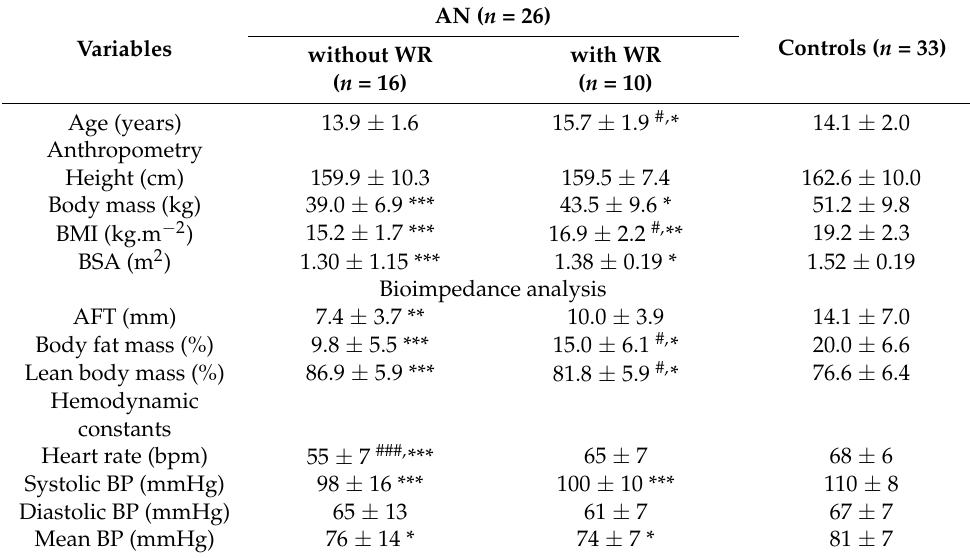
Table 1. Baseline characteristics of AN patients without and with WR and controls.